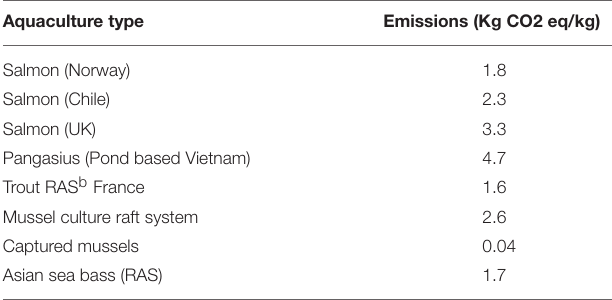
TABLE 4 | CO2 emissions of aquaculture source a